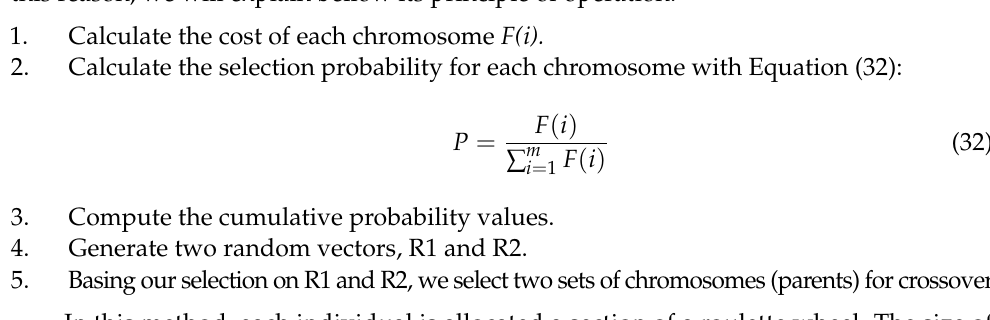
Figure 9. GA PI controller.